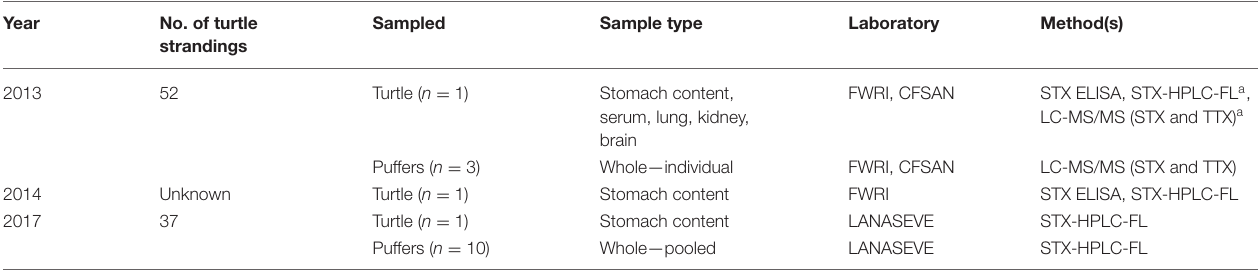
TABLE 1 | Inventory of samples analyzed for saxitoxins (STXs) and tetrodotoxin (TTX) by mortality event, laboratory, and